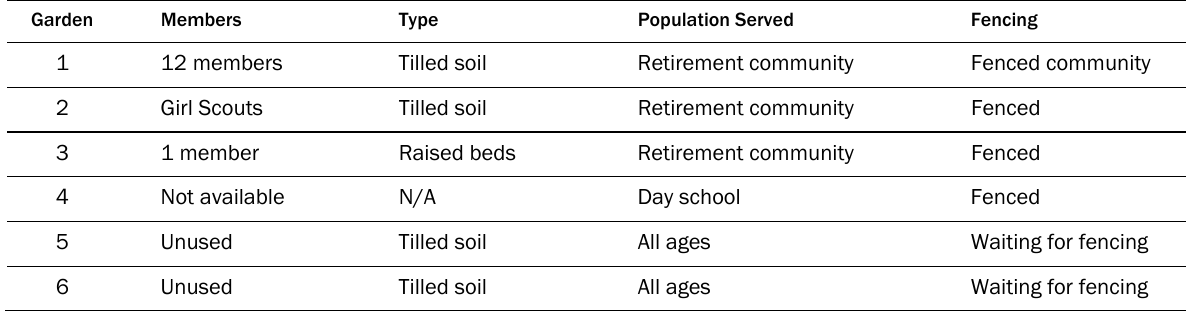
Table 1: Community Gardens Within Neighborhoods, Listed in Descending Order of Use